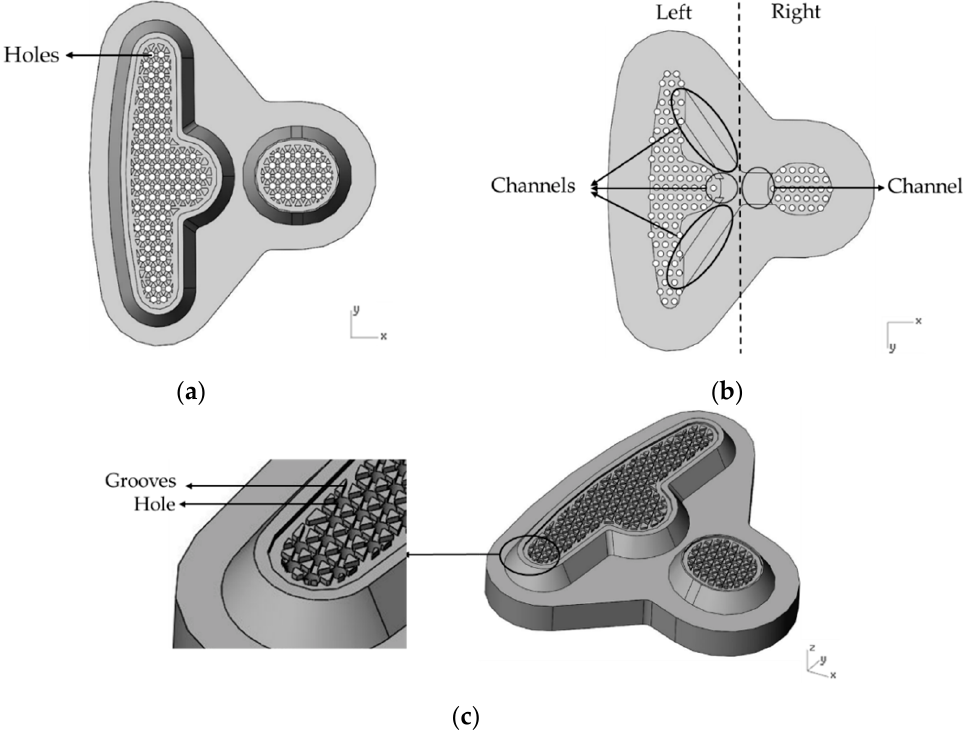
Figure 5. The design of the Teflon module. ( a ) Top view of the Teflon block; ( b ) bottom view of the Teflon block; and ( c ) the microstructure of the Teflon block.